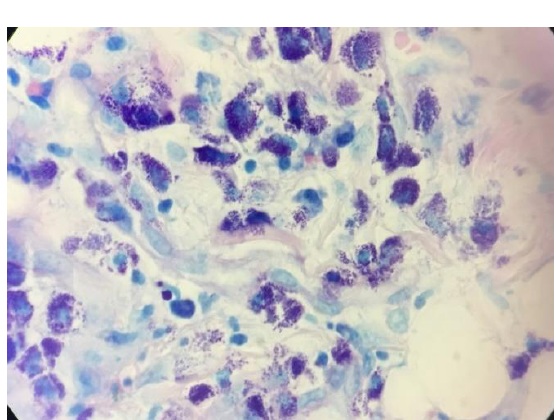
Figure 7. Peritoneal biopsy showed pleomorphic mast cells with metachromatic granules. (Giemsa, 400×) Other findings during surgical exploration included spleen enlargement with whitish surface, and peritoneal tumor implants, which was confirmed by biopsy and microscopic pathologic